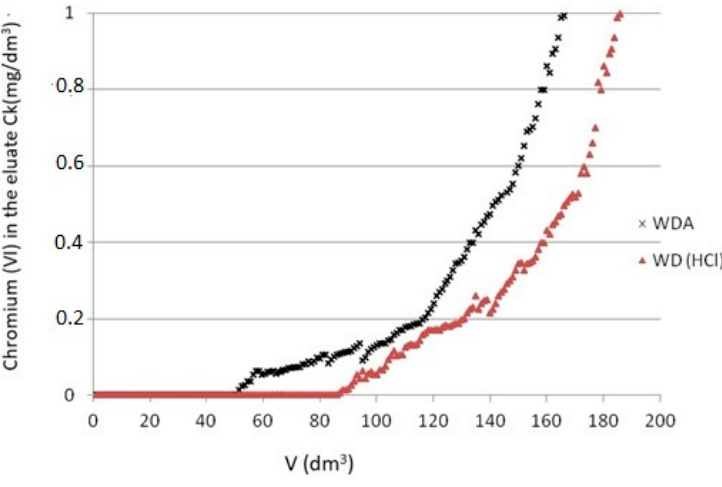
Figure 6. Adsorption isoplanes of Cr (VI) for WDA and WD (HCl), C 0 = 1 mg/dm 3 , T R = 420 s.